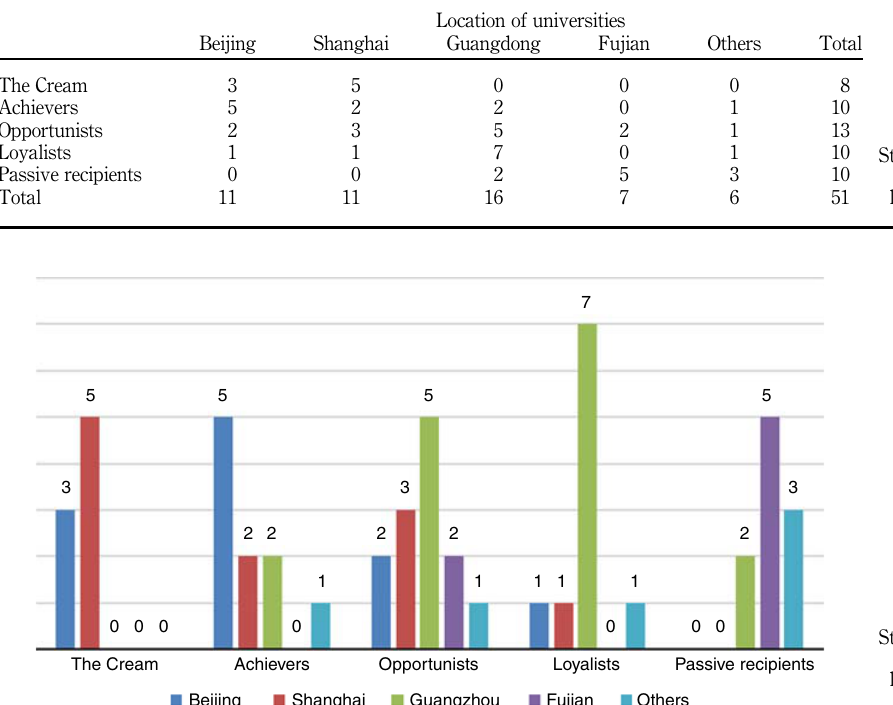
Table VI. Students ’ choice under five scenarios by location of university